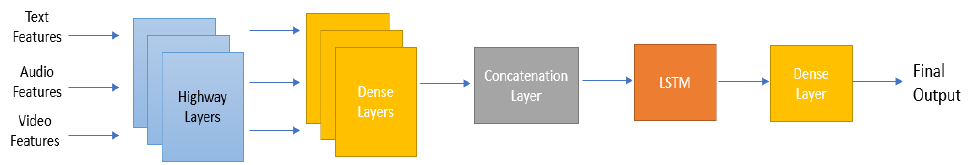
Figure 4. SVM and RF model architecture. LSTMs with or without gating: The gating mechanism is used for learning the effects of visual and auditory modalities on lexical information. This mechanism is important for determining the noise quantity while combining the three modalities with different effects to obtain the final result. The main motivation for using the gating mechanism was to overcome the undermining problem with the learned representation of text using other modalities. By using a gating mechanism, the contributions of visual and auditory modalities to the final result can be controlled [52]. The model includes feed-forward highway layers [88] for use with the gating mechanism for audio and video features. Those layers have two non-linear transforms (the ‘carry gate (Cg)’ to measure the transformation degree and ‘transform gate (Tg)’ to determine the amount of information to move forward). The definitions of the gates are as follows: